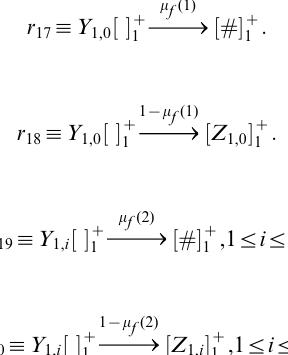
Fifth configuration (Initial configuration) Control density birds retire and rats and